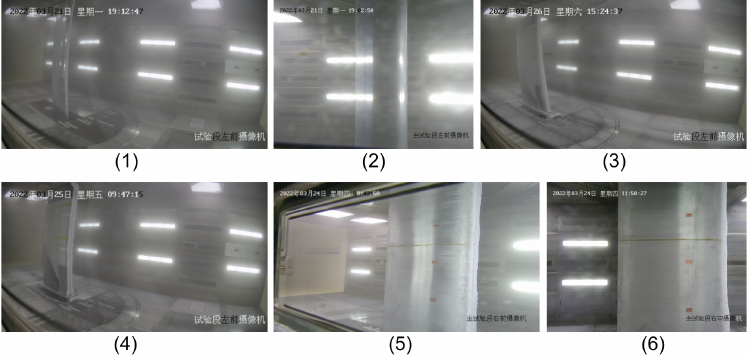
Figure 4. Some sample images from the icing wind tunnel. (( 1 – 6 ) in the picture represent Image 1 to Image 6).